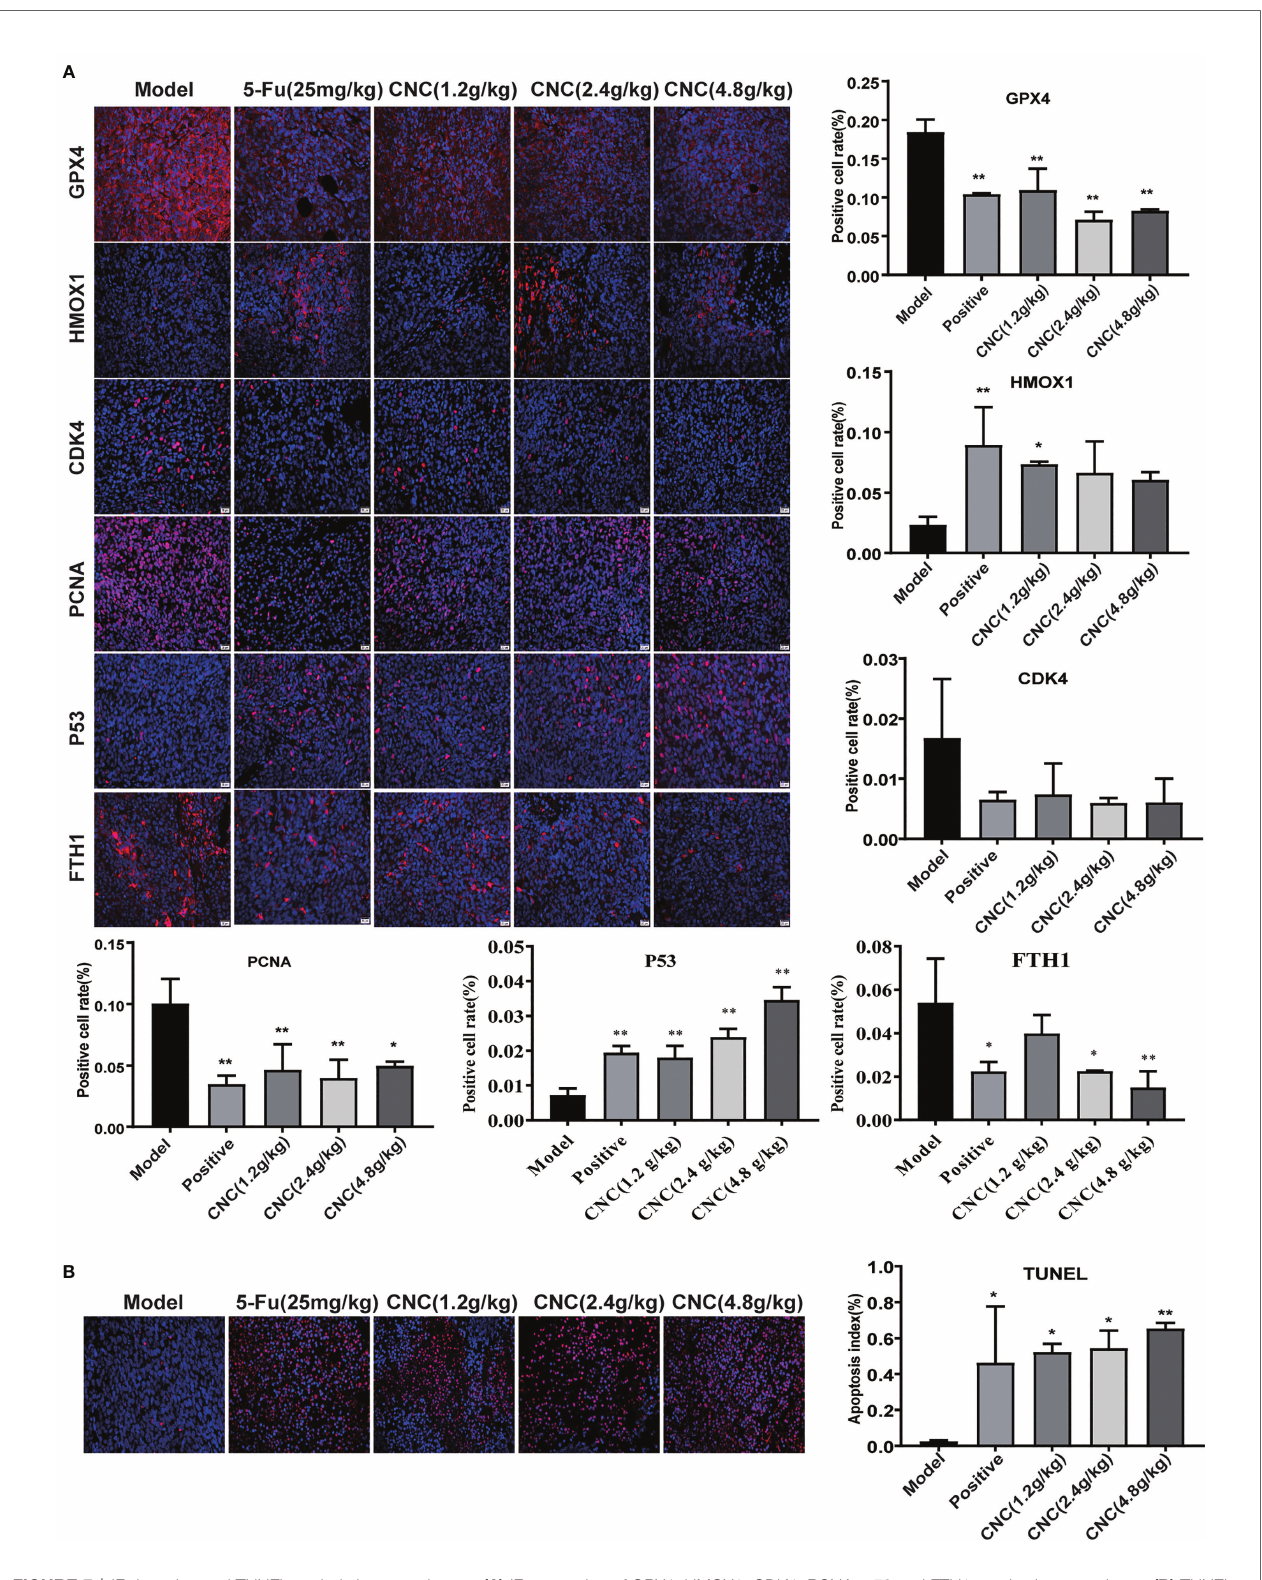
FIGURE 7 | IF detection and TUNEL analysis in tumor tissues. (A) IF expression of GPX4, HMOX1, CDK4, PCNA, p53 and FTH1proteins in tumor tissue. (B) TUNEL analysis in tumor tissues. There were six nude mice in each group. Data are expressed as mean ± SD. Compared with model group: *p < 0.5, **p <